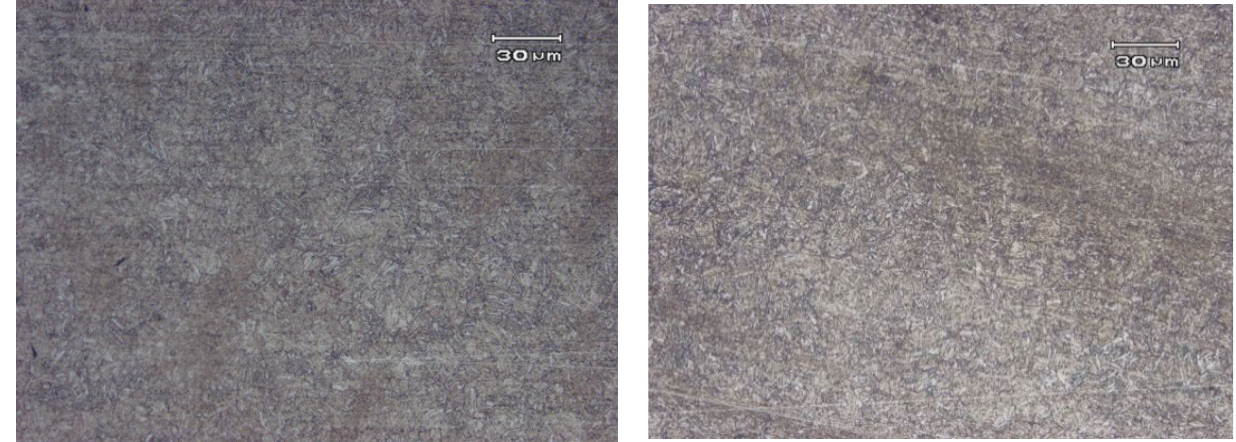
Figure 4. Vibration spectrum.